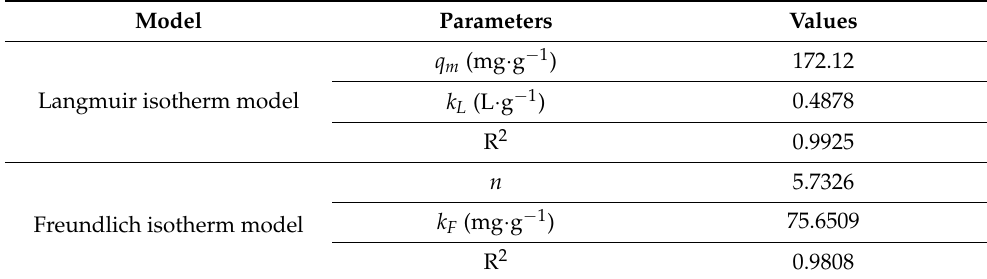
Table 2. Comparison of kinetic parameters between the Langmuir and Freundlich models of Cr(VI) adsorption with PVDF–2GO@GO ENFM.